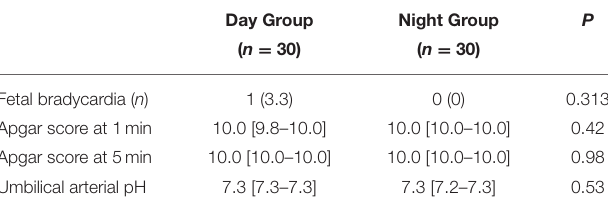
TABLE 3 | Neonatal